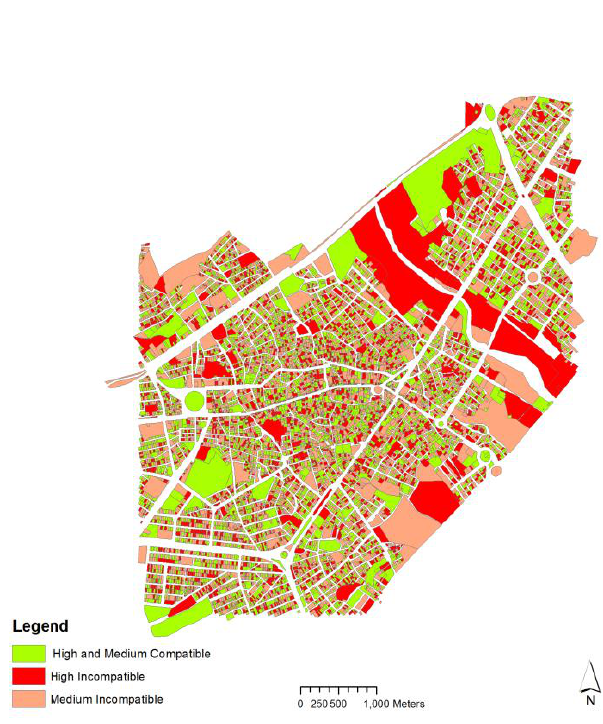
Figure 3. Results of